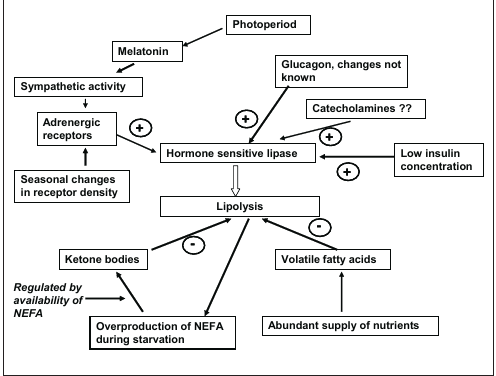
Fig. 4. Regulation of hormone sensitive lipase (HSL) and lipolysis in adipose tissue. + indicates a factor that increases the activity of HSL and – indicates